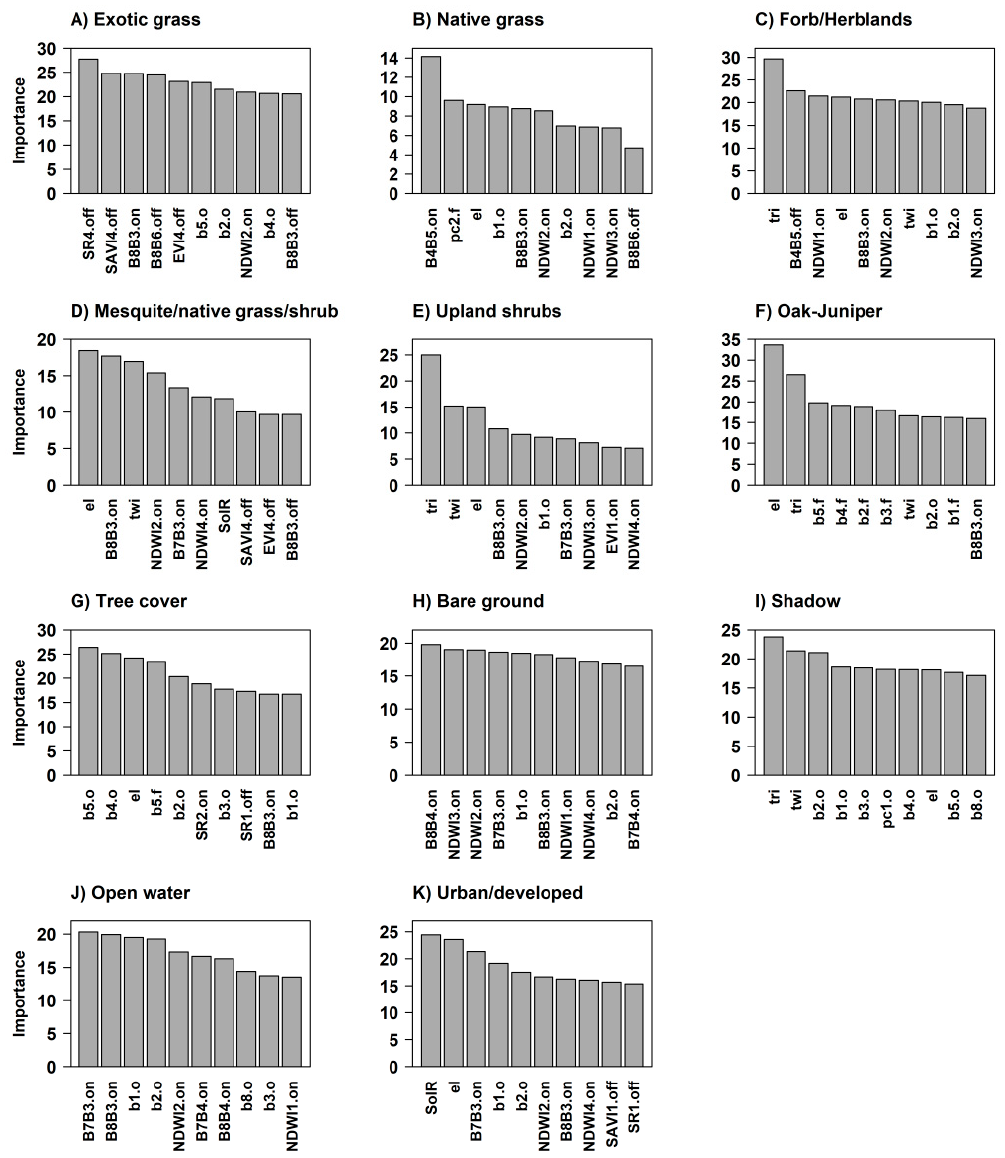
Figure 14. Random Forest land cover classification model variable importance (mean decrease in accuracy with each predictor variable held out at each model training iteration) for the first 10 most important variables.